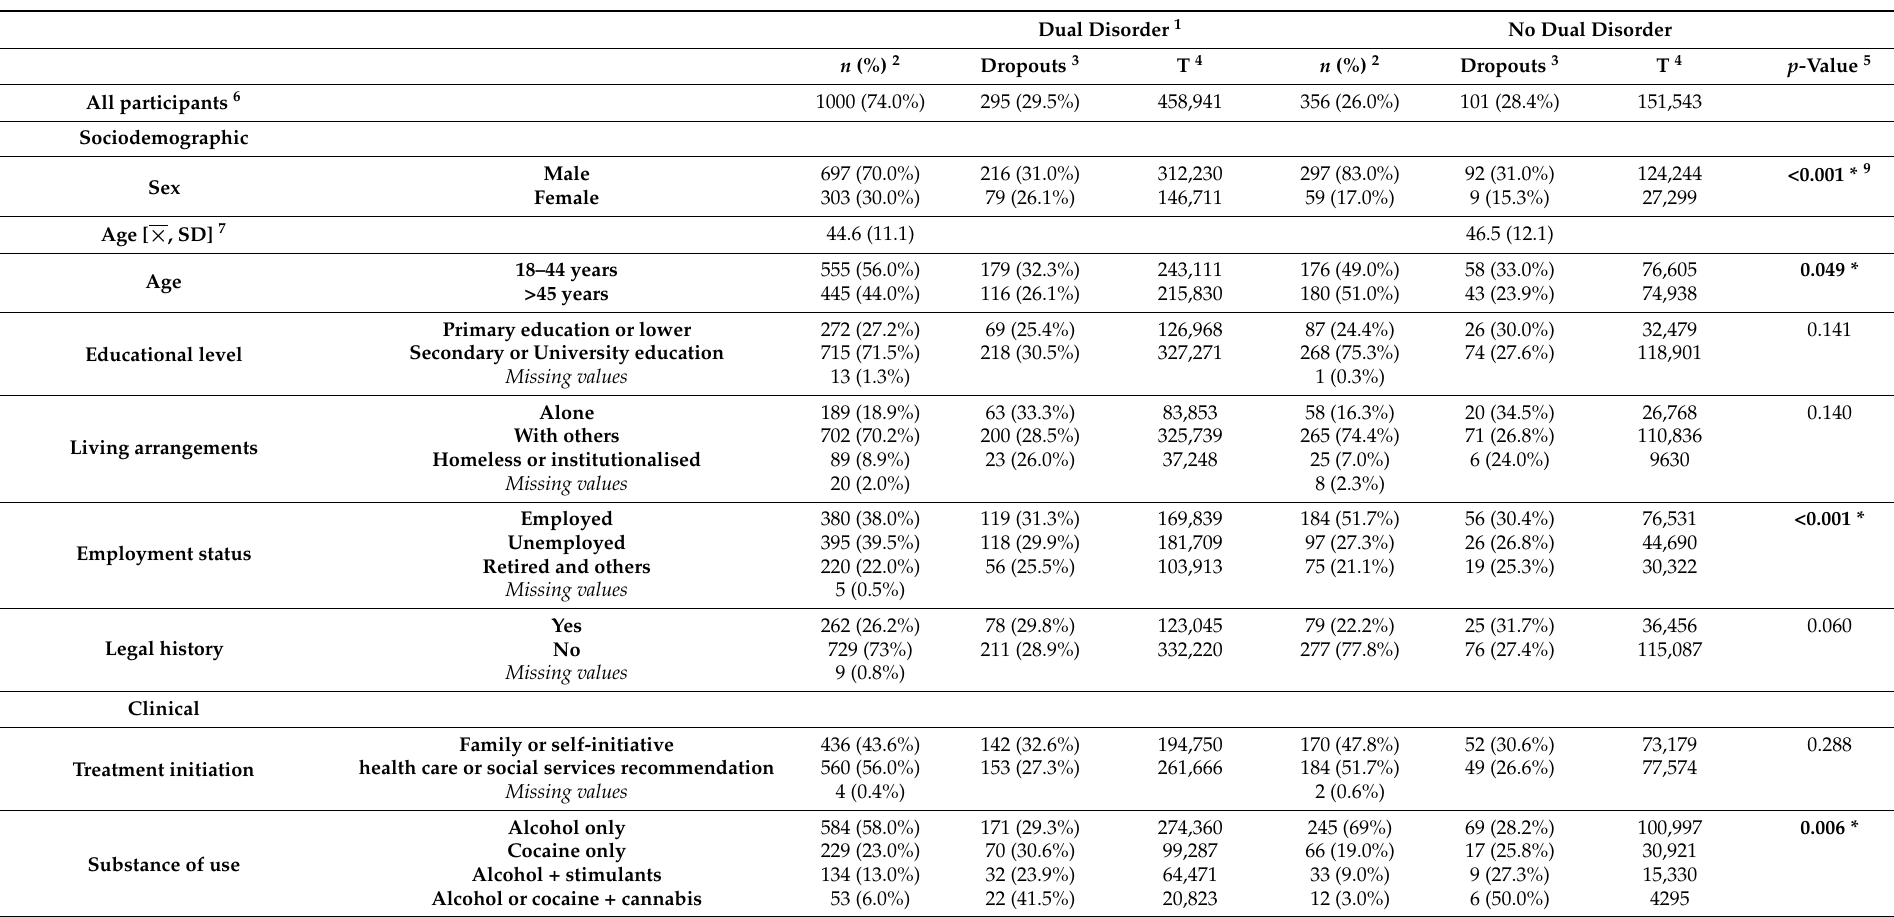
Table 1. Sociodemographic, clinical and treatment retention characteristics of a cohort of individuals with alcohol or cocaine use disorder ( n = 1356) by DDSI-IV result. Outpatient drug dependence care centres in Barcelona, January 2015–February